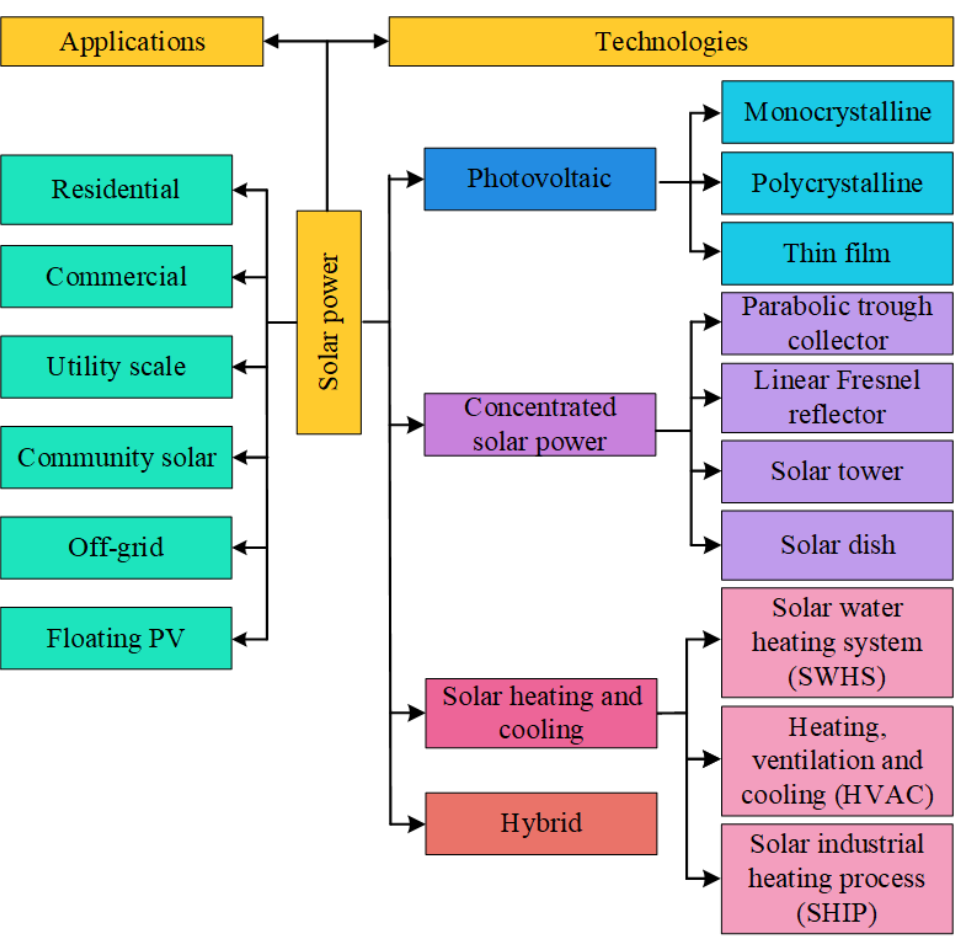
Figure 5. Breakdown of different solar technologies and application